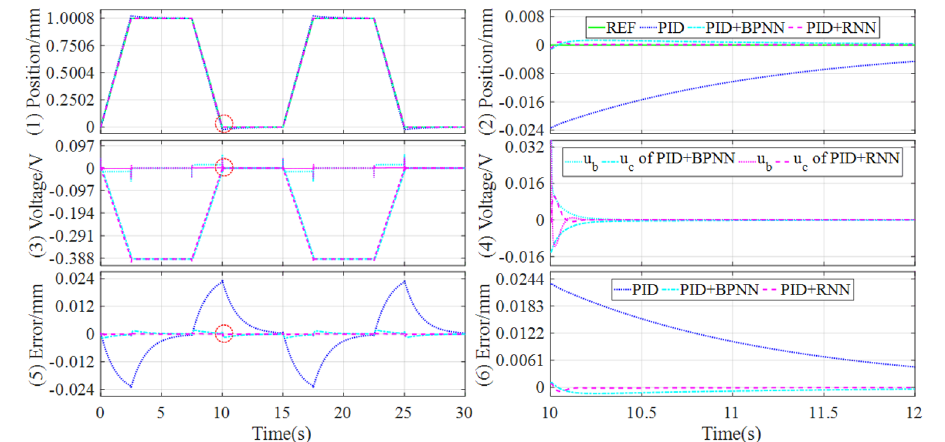
Figure 8. Simulation results of tracking trapezoidal signal under the different controllers.